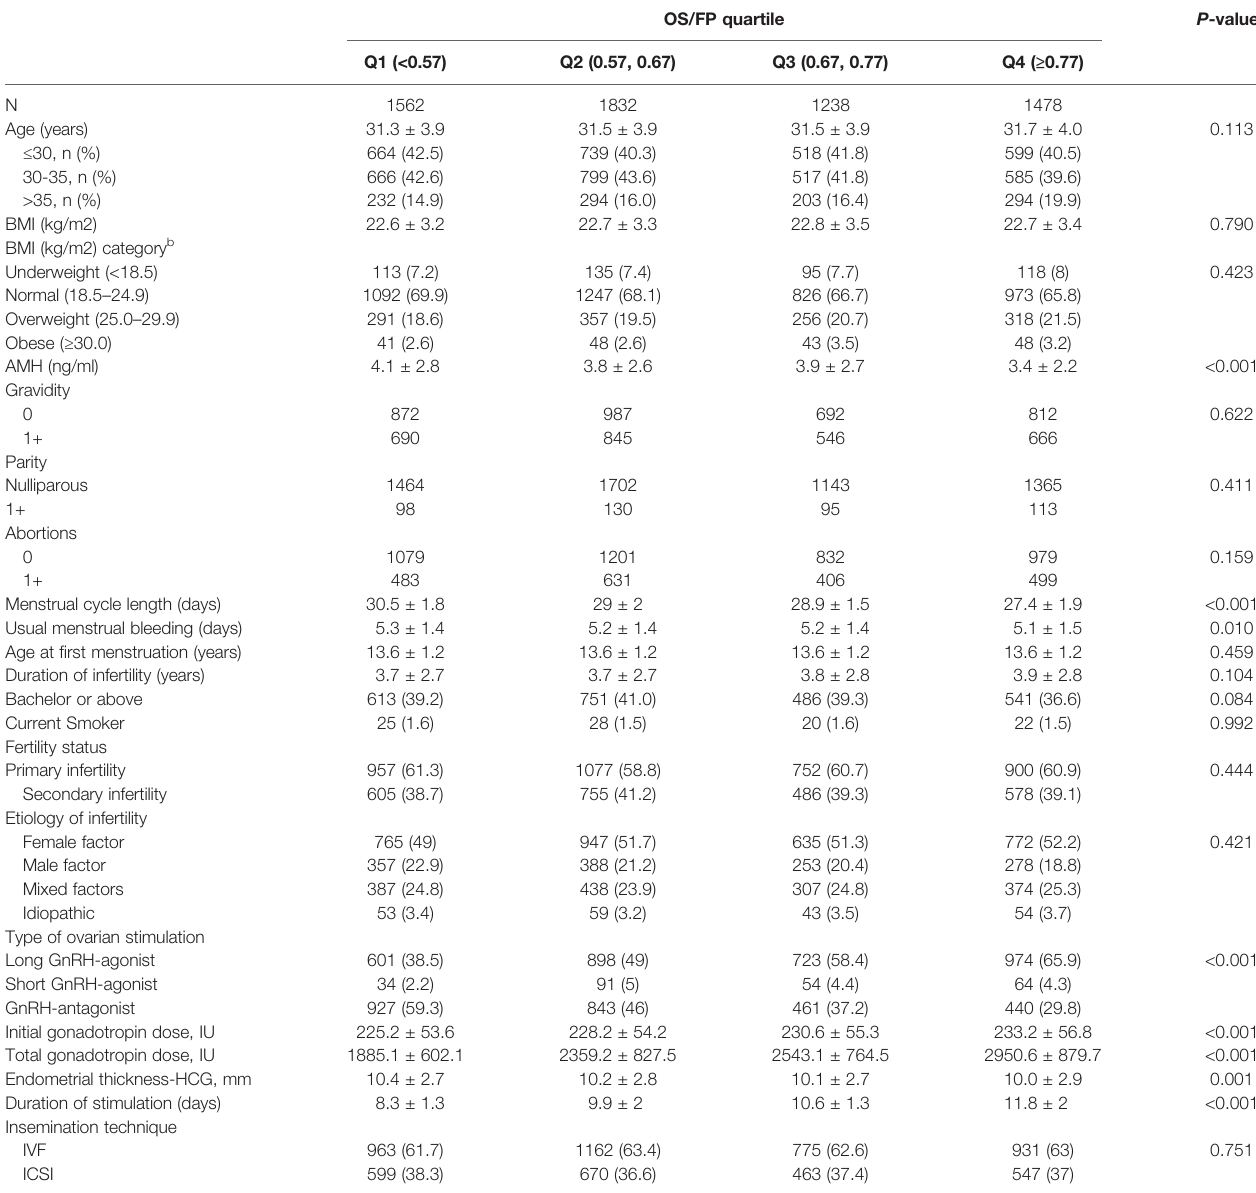
Valuesaren(%)forcategoricalvariablesandmean±SDforcontinuousvariables.SD,standard deviation;OS/FP,theratioofdurationofovarianstimulation tofollicularphase length;BMI, body mass index; AMH, anti-mullerian hormone; IVF, in vitro fertilization; ICSI, intracytoplasmic sperm injection. Data on covariates were missing for BMI (n = 109), endometrial thickness-HCG (n = 99). a P values were calculated from nonparameter test (Kruskal-Wallis) or c 2